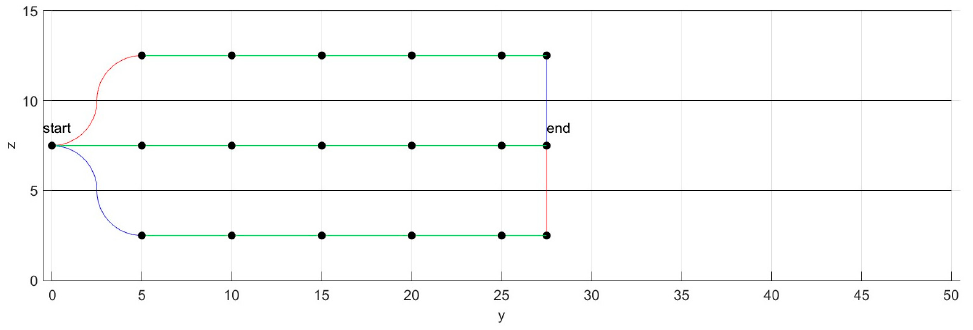
Figure 11. y-z view of Figure 10.